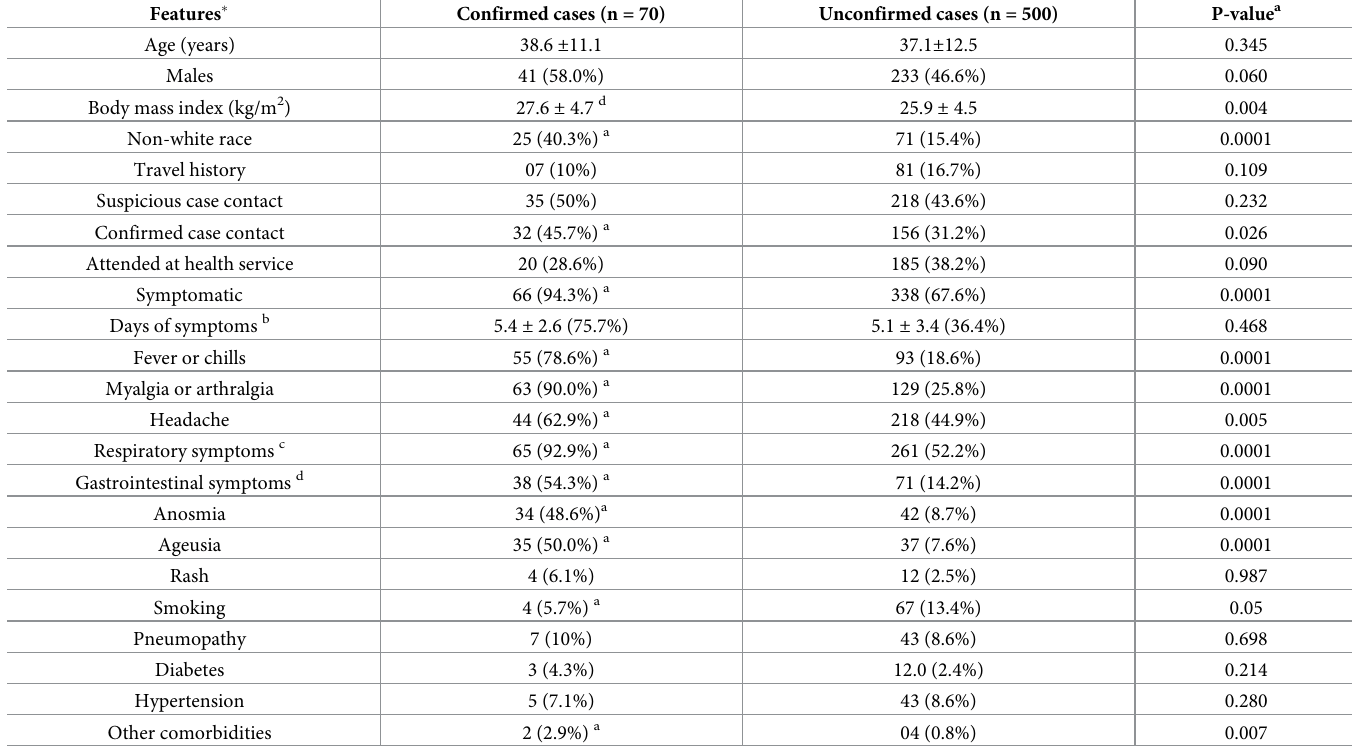
Table 1. Sociodemographic, epidemiological, and clinical data of the 570 subjects included in the present study. Features